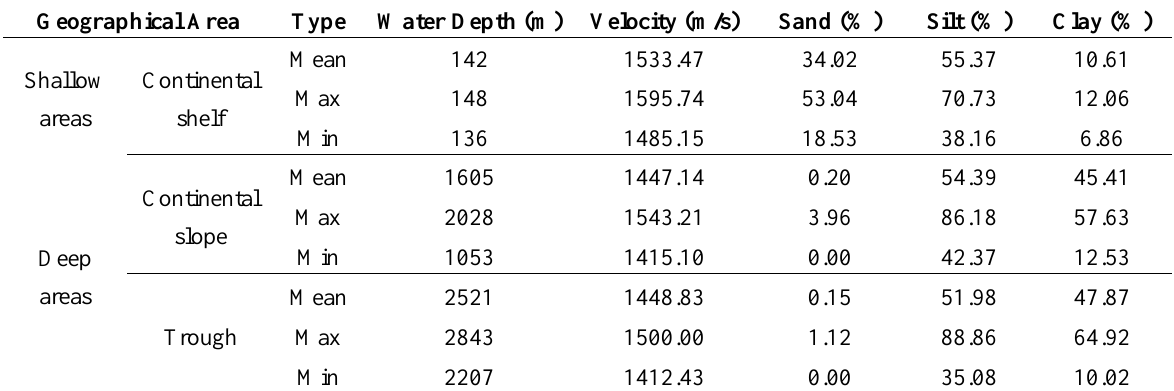
Table 2. Sand-silt-clay ratios and water depth in different geographical areas. Geographical